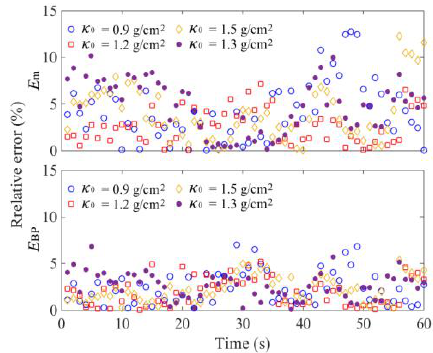
Figure 13. Experimental results of relative errors.